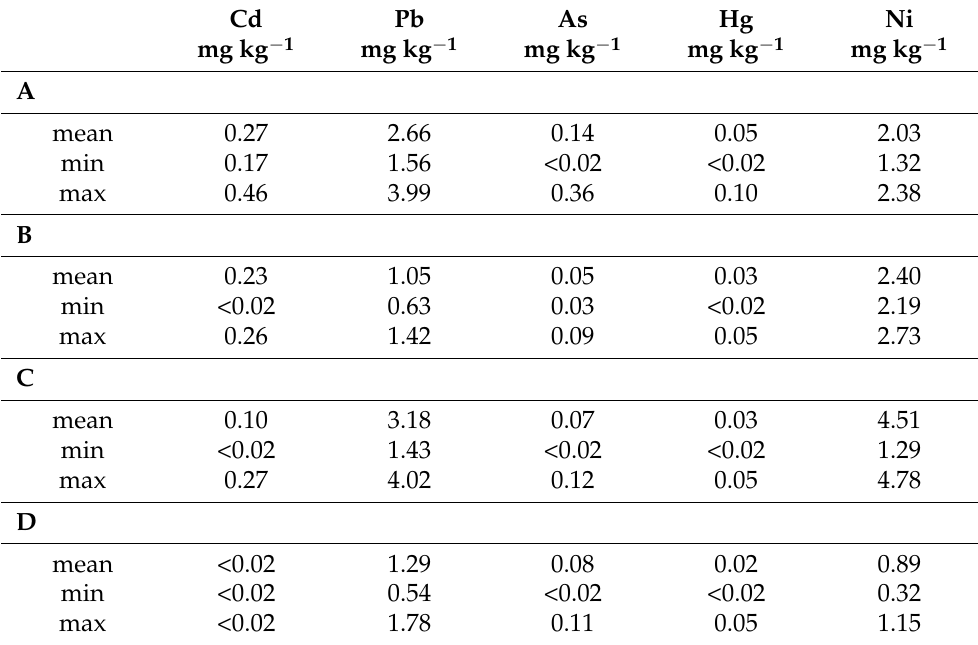
Table 4. The total content (mg/kg) of toxic elements (Cd, Pb, As, Hg, and Ni) in dry